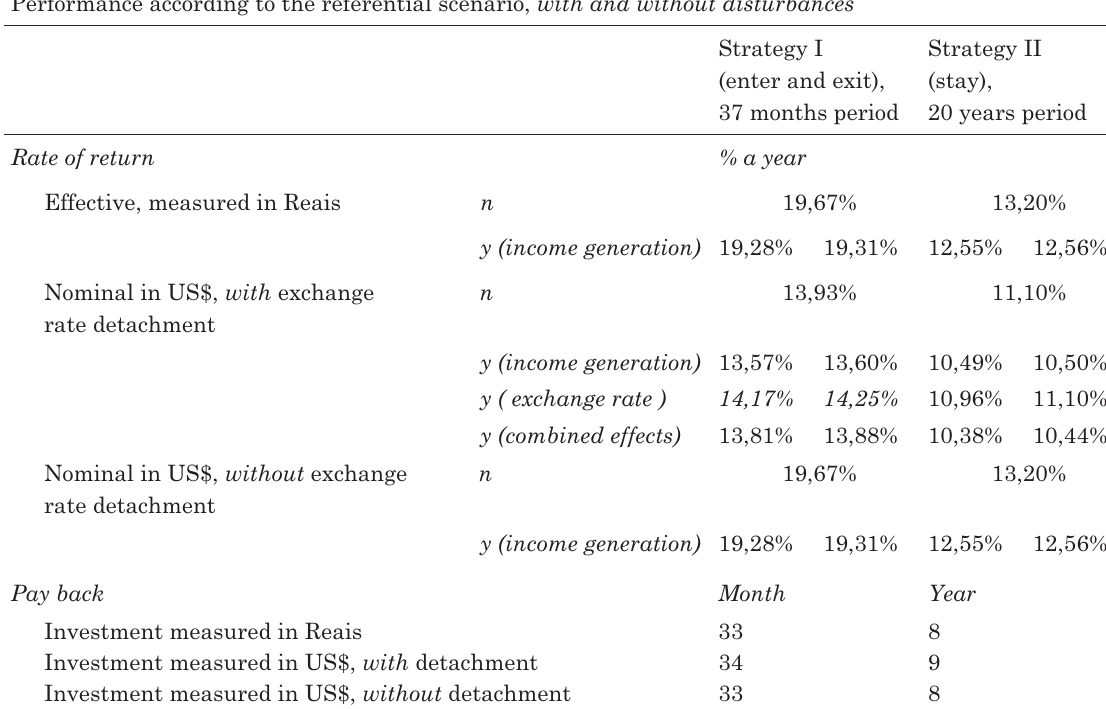
Table 6. Investment quality indicators – rate of return and pay back according to different strategies Performance according to the referential scenario, with and without